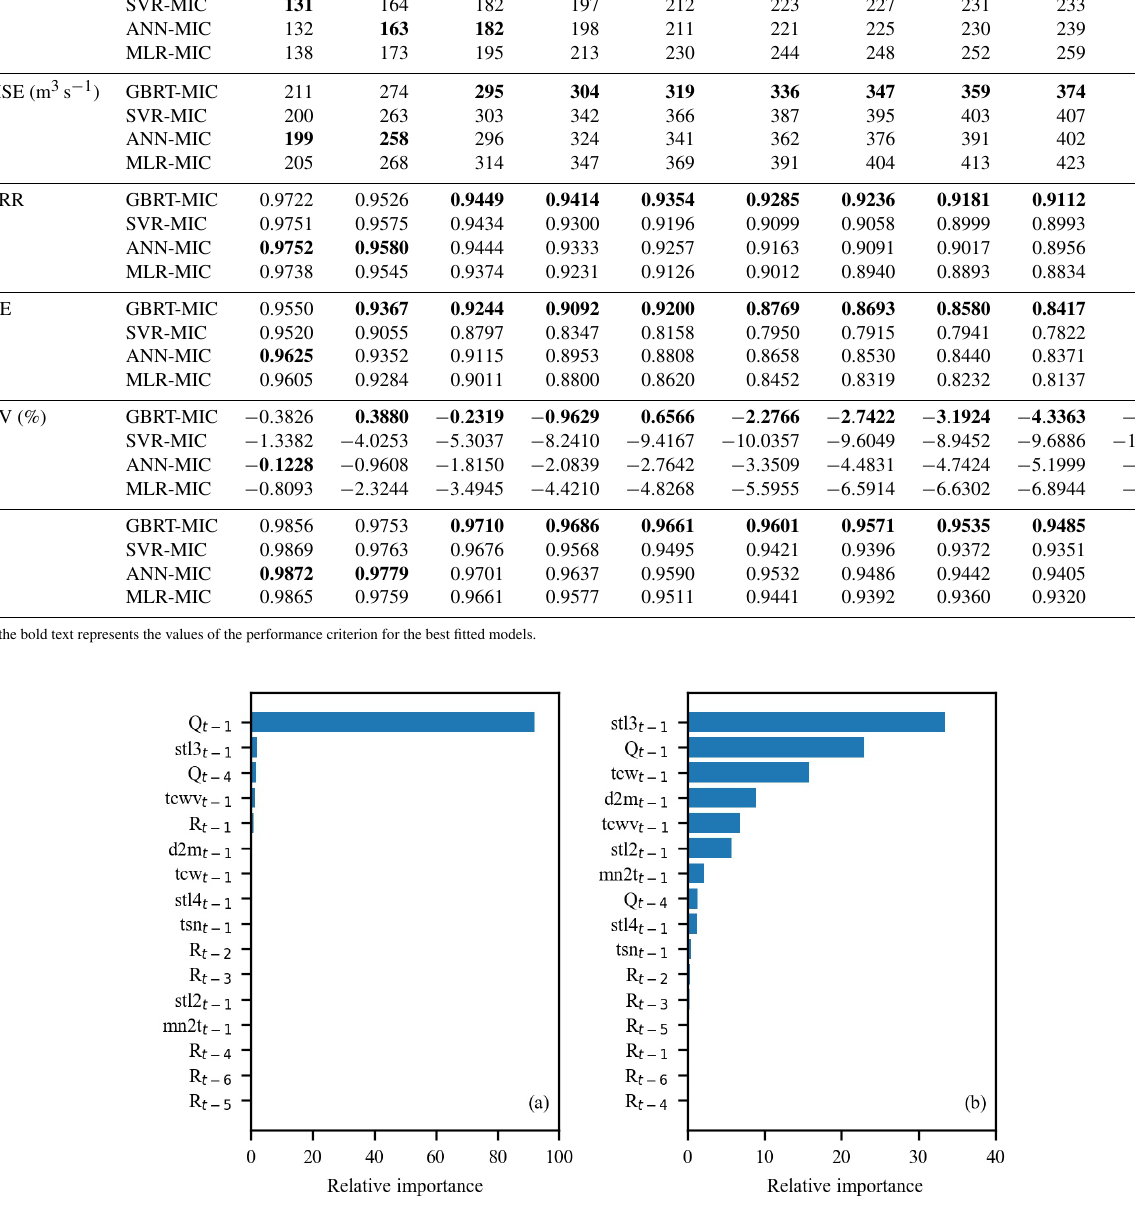
ues. According to a comparison of the forecasted results of GBRT and GBRT-MIC, we conclude that GBRT-MIC